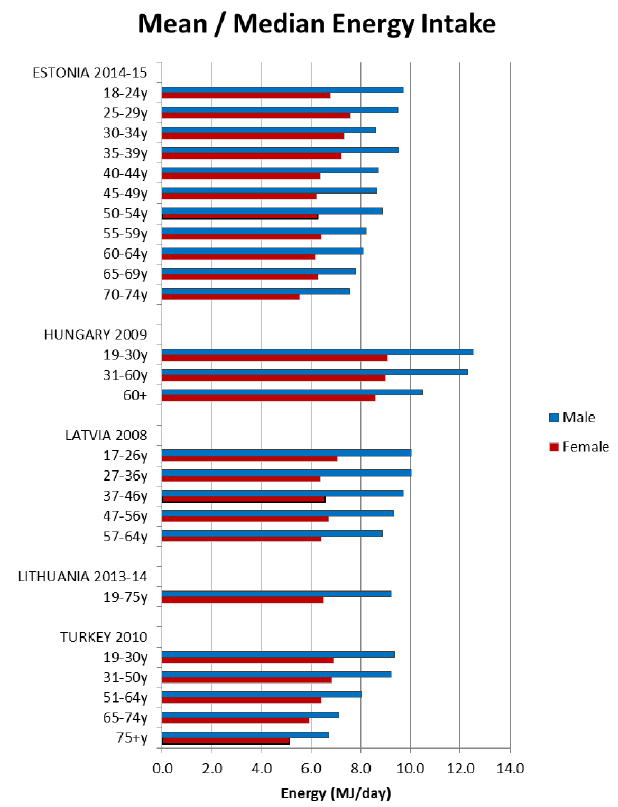
Figure 3. Mean/median adult energy intake (MJ/day) for Central & Eastern European countries (excluding supplements).